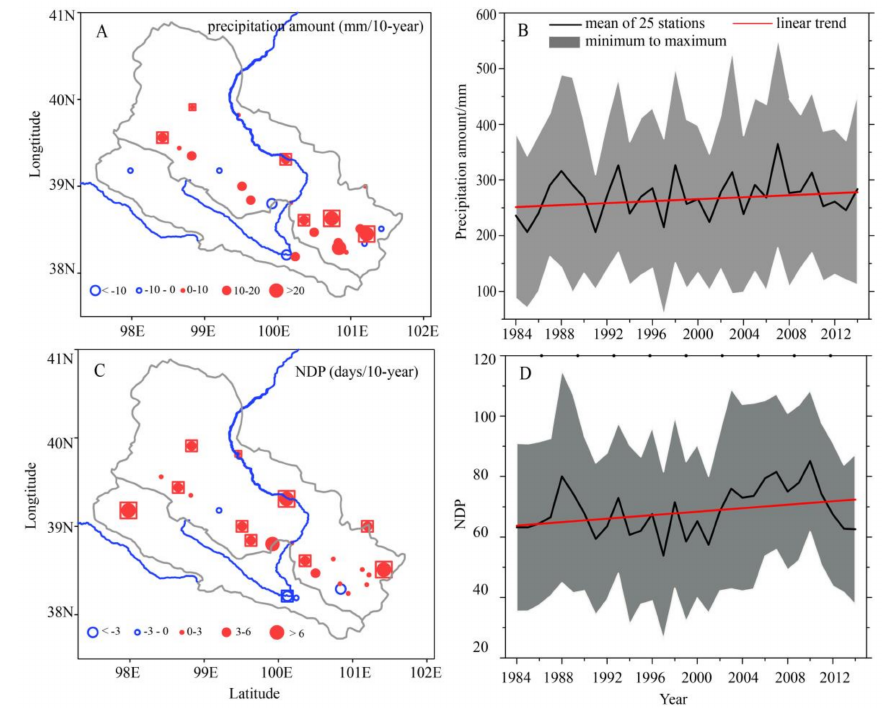
Figure 4. The linear trend of annual precipitation amount ( A , B ) and number of days with precipitation (NDP; ( C , D )) for the 25 stations from 1984 to 2014. In ( A ) and ( C ), the dots inside squares denote significance at a level of 0.1.